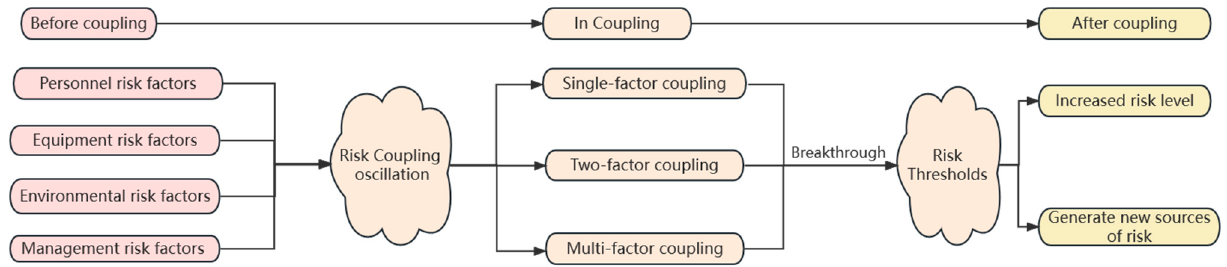
Figure 3. Mechanism of the coupling of safety risks in tunneling construction (source: plo tt ed with reference to [37]). reference to